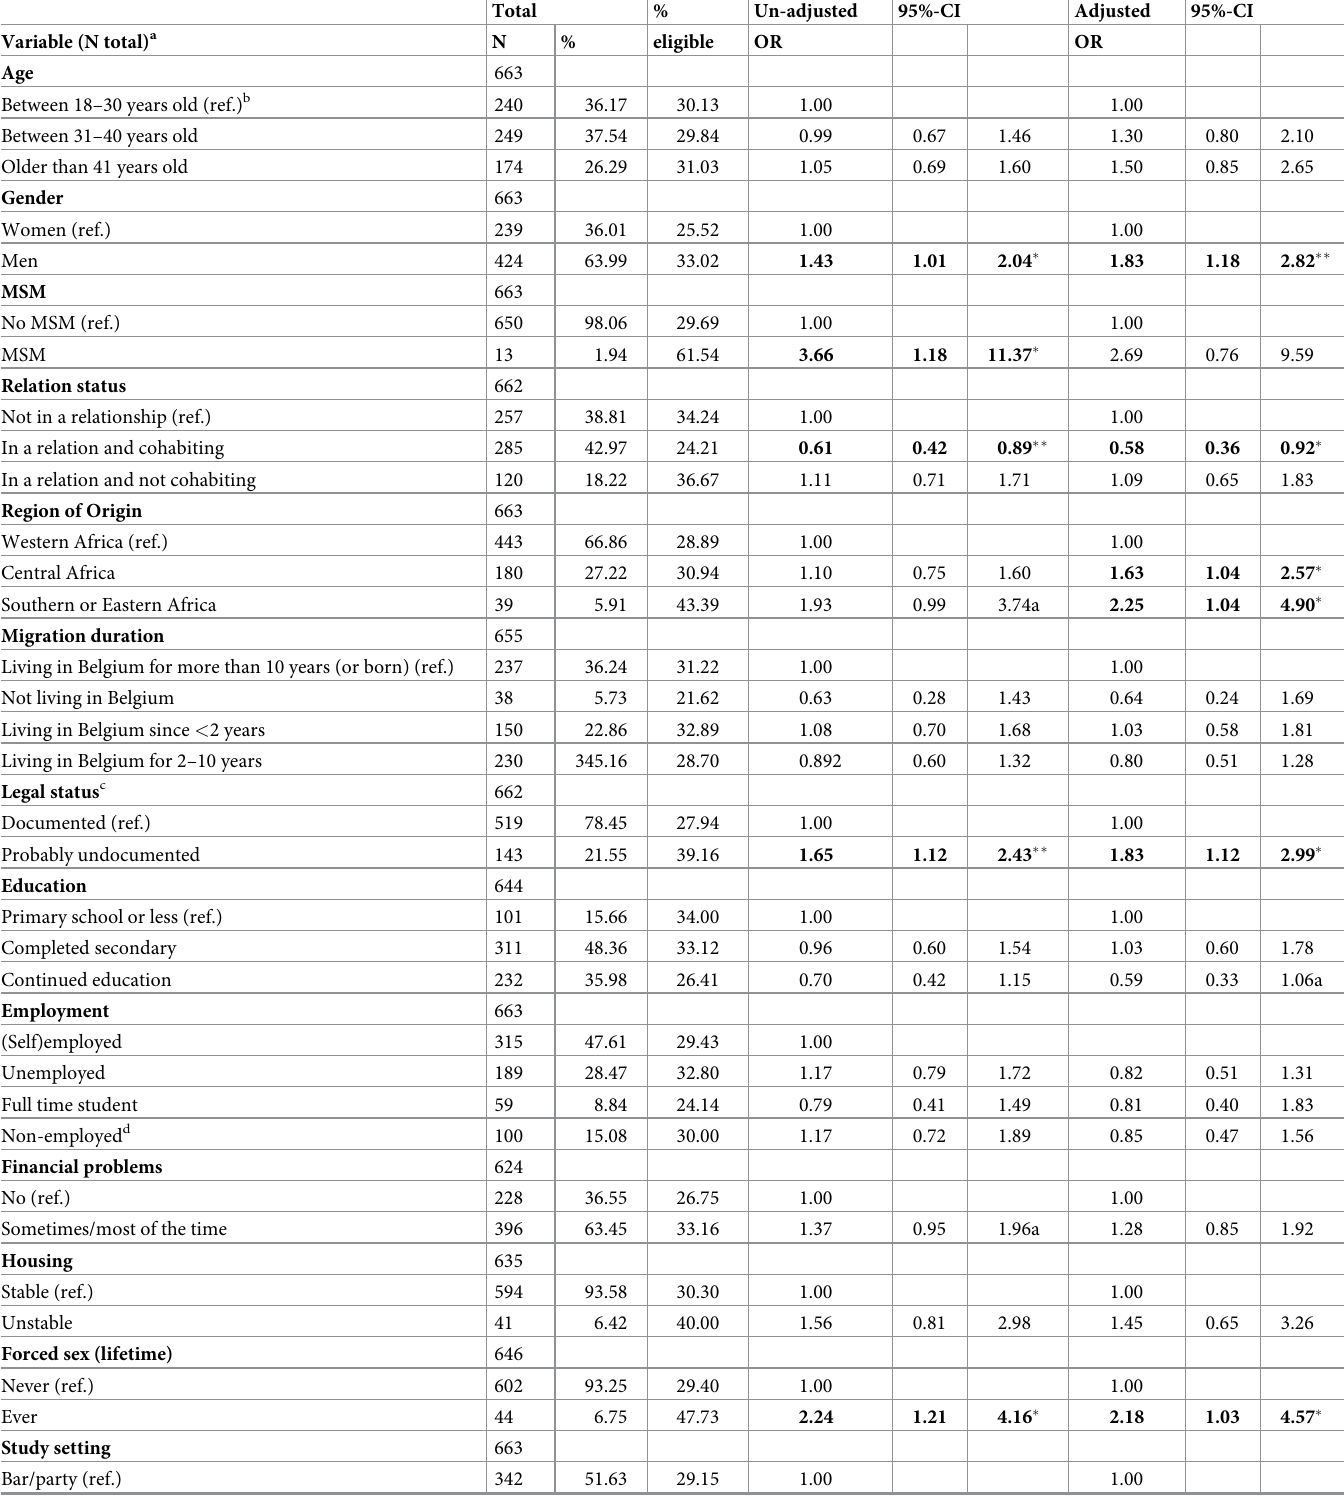
Table 1. Factors associated with eligibility to PrEP in bivariate and multivariable logistic analysis (weighted data). Total % Un-adjusted 95%-CI Adjusted 95%-CI Variable (N total) a N % eligible OR OR Age 663 Between 18–30 years old (ref.)